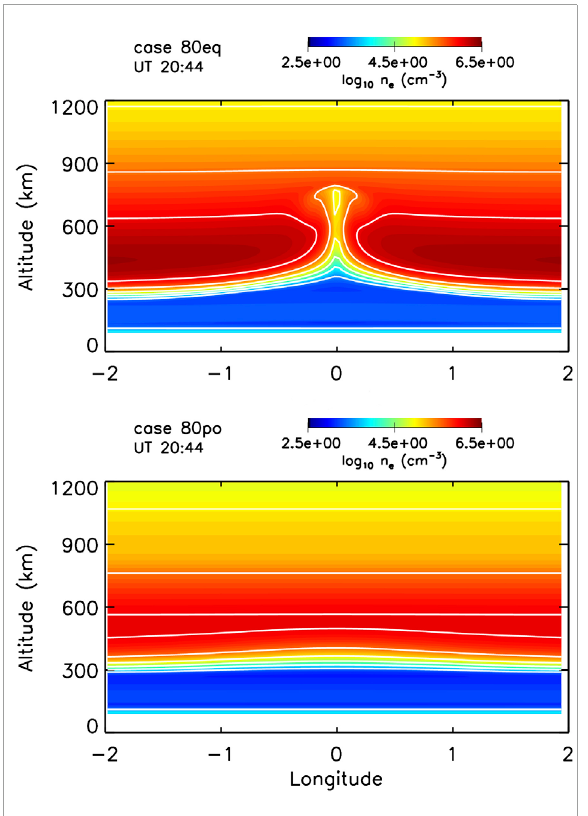
FIGURE 2 Electron density contours as a function of longitude and altitude for a negative wind gradient (top: case 80eq) and a positive wind gradient (bottom: case 80po) (from Huba and Krall, 2013).